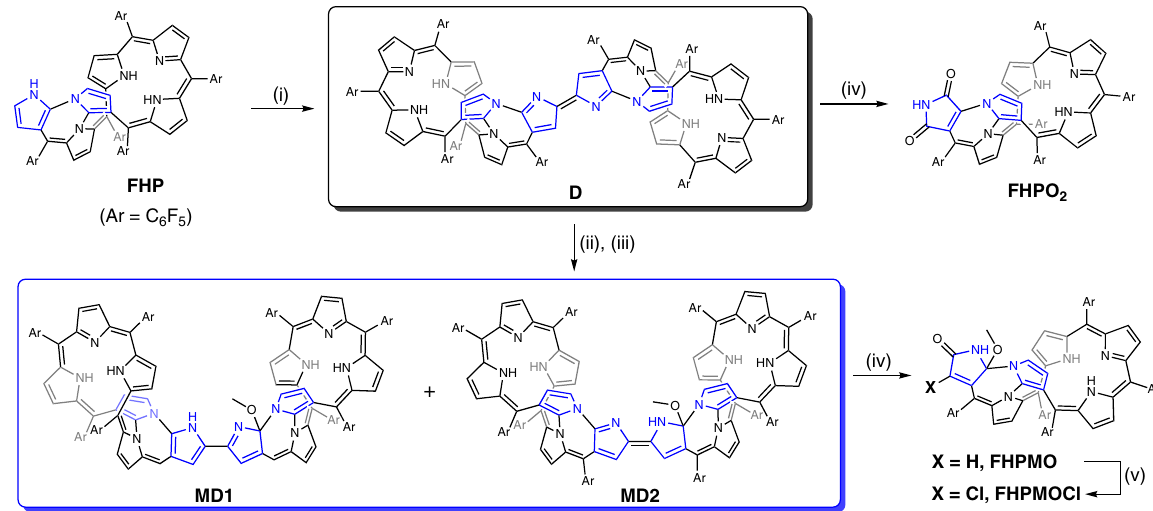
Fig. 2 Syntheses of dimers and monomers considered in this study. Conditions: (i) p -chloranil, CHCl 3 , re fl ux; (ii) Cs 2 CO 3 , THF/MeOH; (iii) TFA, THF/ MeOH; (iv) CF 3 COOAg, CH 2 Cl 2 /MeOH; (v) FeCl 3 , CHCl 3 /MeOH, re fl ux. The blue-colored pyrrolic units represent confused pyrroles that are linked with adjacent pyrroles or meso-carbons through C α -C β or N-C β